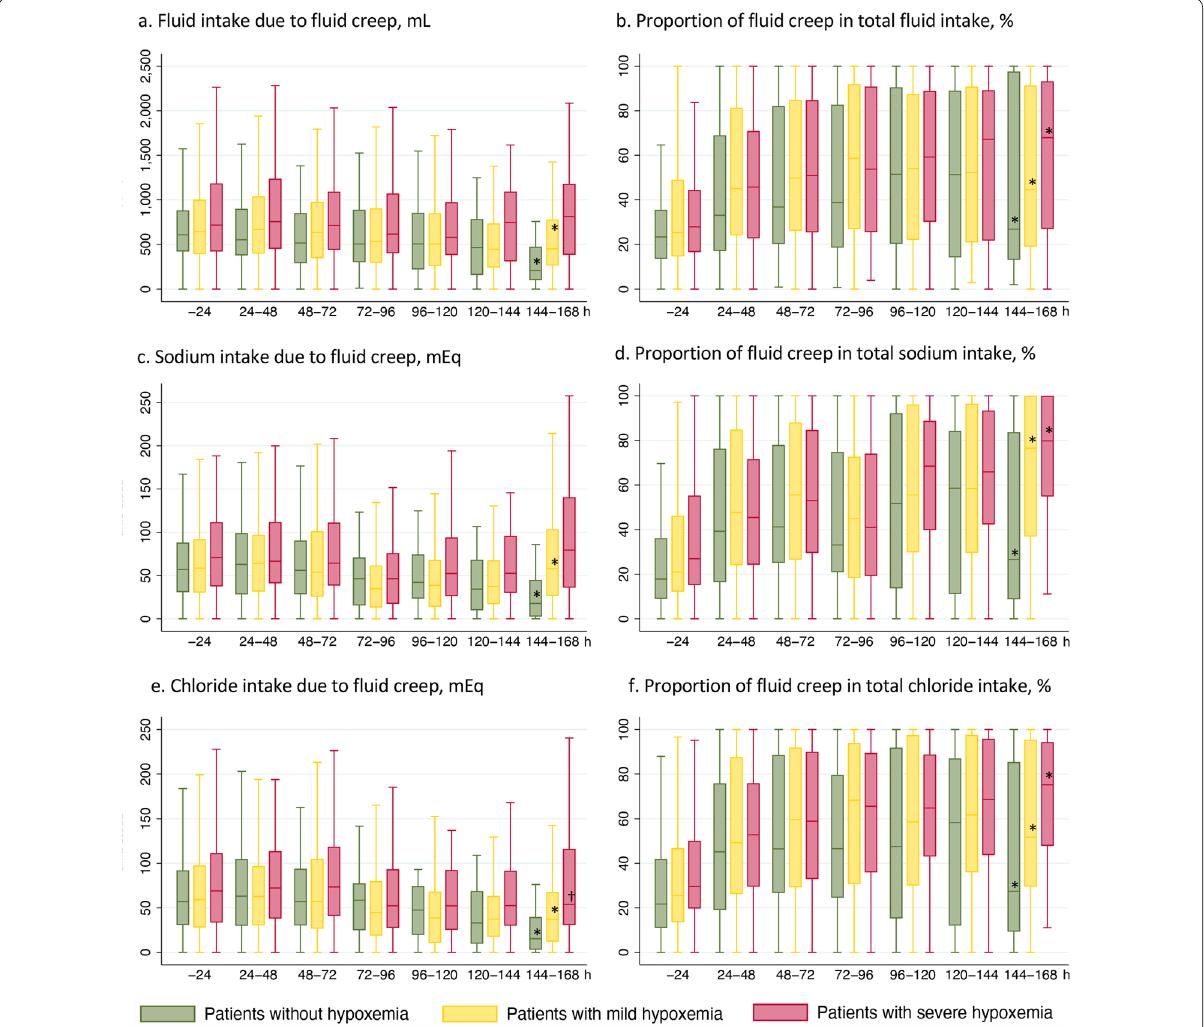
Fig. 3 Daily intake of fluid, sodium, and chloride due to fluid creep. a Fluid intake due to fluid creep; b proportion of fluid creep in total fluid intake; c sodium intake due to fluid creep; d proportion of fluid creep in total sodium intake; e chloride intake due to fluid creep; f proportion of fluid creep in total chloride intake. * P for trend < 0.001; † P for trend < 0.01. There was no significant trend between intensive care unit days and the amount of fluid creep ( P for trend 0.159) and in sodium of fluid creep ( P for trend 0.105) in patients with severe = =